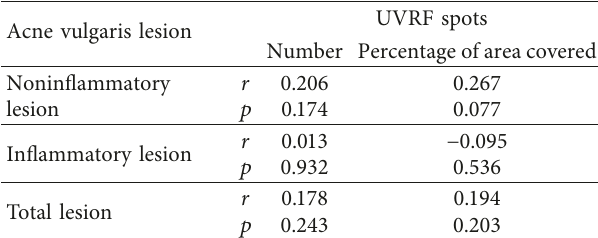
Percentage of area covered Table 3: Correlation between the type of acne vulgaris lesions with UVRF parameters.